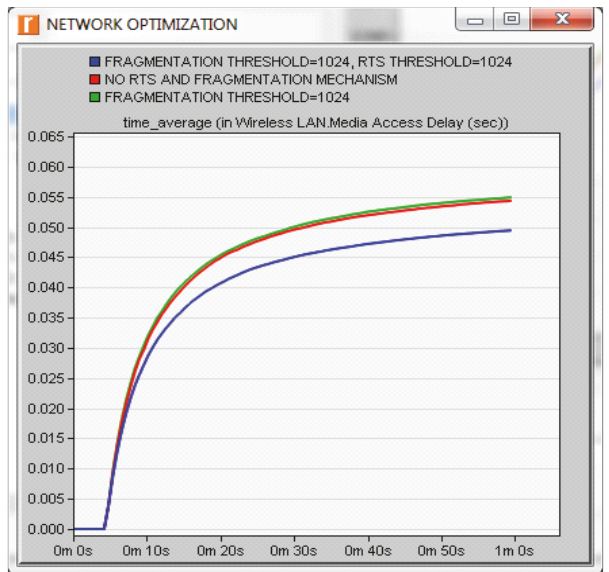
Figure 19: WLAN delay optimization with RTS and fragmentation mechanism.